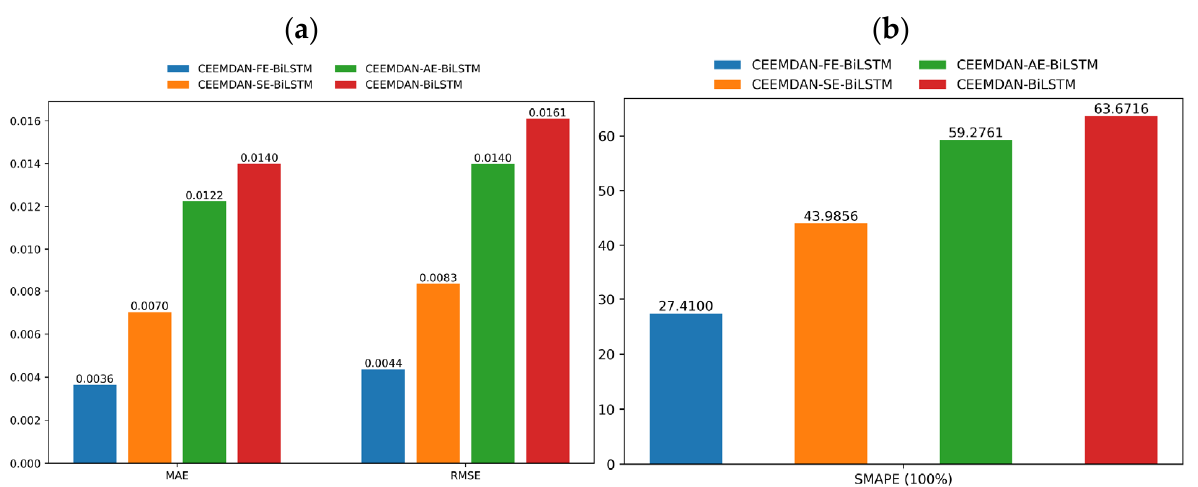
Figure 10. Comparison of horizontal error of O 3 concentration prediction model: ( a ) MAE and RMSE ; ( b ) SMAPE .